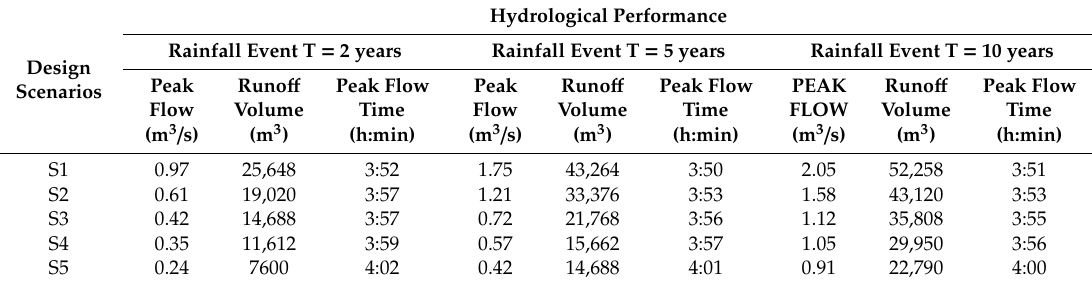
Figure 11. Simulated hydrographs for three storm return periods and five design scenarios. Table 5. Hydrological performance for rainfall events of three return periods.